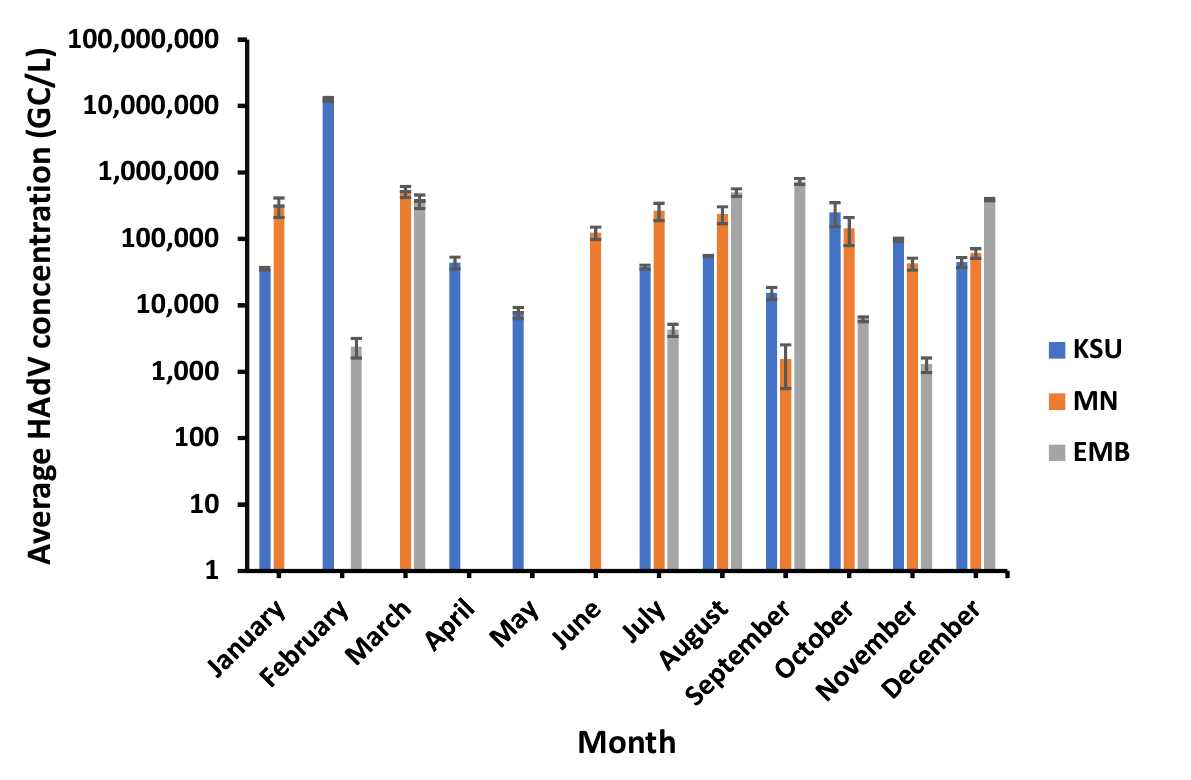
Figure 6. HAdV concentration in raw water of the different WWTPs.